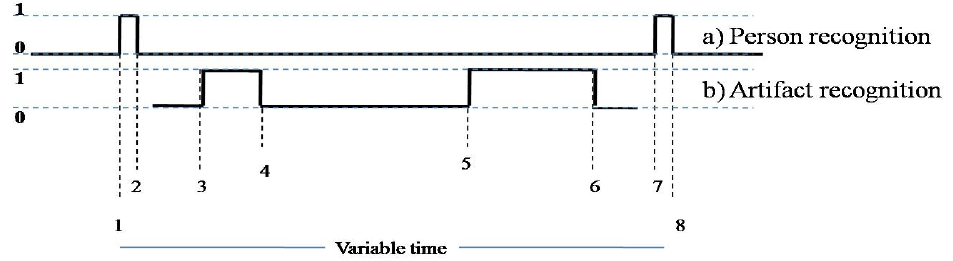
Figure 9. Two technologies used ( a ) Person recognition using RFID technology; ( b ) Artifact recognition through image